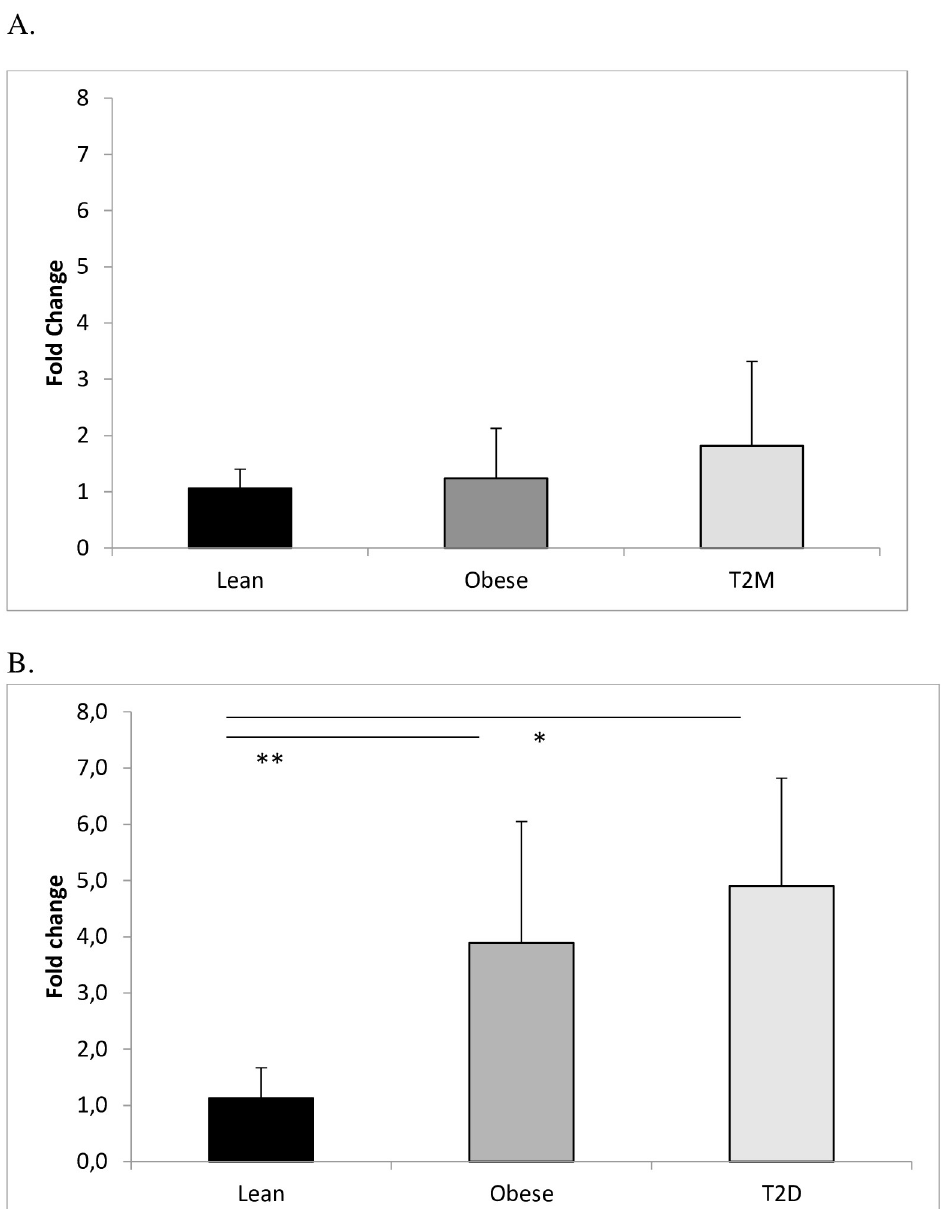
Fig 3. Gene expression levels of PAI-1 in A. platelets compared with reference genes and B. in subcutaneous adipose tissue compared with reference genes. There were no significant differences in gene expression levels of PAI- 1 in platelets between participants with T2D, obese and lean control subjects (T2D n = 6, obese n = 7 and lean control subjects n = 7)(A.). There was a significant difference in gene expression levels of PAI-1 in subcutaneous adipose tissue between lean control subjects and T2D or obese non-diabetic control subjects (T2D n = 7, obese n = 6 and lean control subjects n = 6) � P = 0.003, �� P = 0.038 (B.). Abb. PAI-1: Plasminogen Activator Inhibitor -1; T2D: type 2 diabetes.